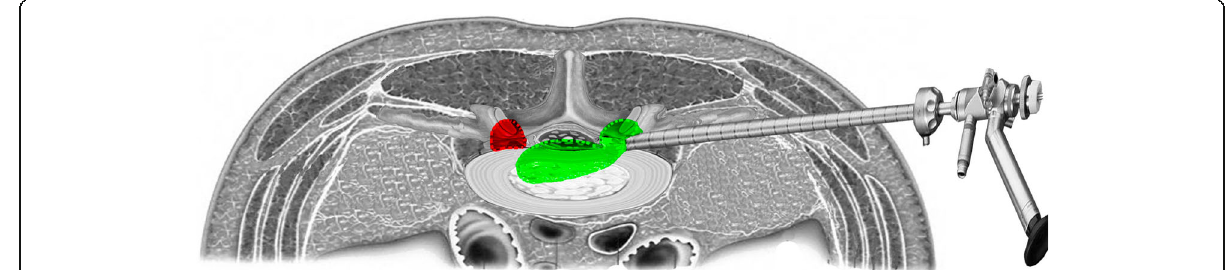
Fig. 4 Illustrative image showing the ventral reach (area green) of a flatly placed trans-foraminal endoscope. It can reach to posterior 1/3rd of the disc and up to middle of the spinal canal and across to opposite side ventral to opposite traversing root. It is best positioned to decompress ventrally (central big disc, hardened/calcified/redundant annulus, or end plate spurs without cord retraction. The endoscopic visualized foraminoplasty can decompress ipsilateral dorsal and lateral aspect of canal optimally, removing part of facet, ligamentum flavum, and capsule of facet (area green). But it cannot target the opposite subarticular stenosis (area